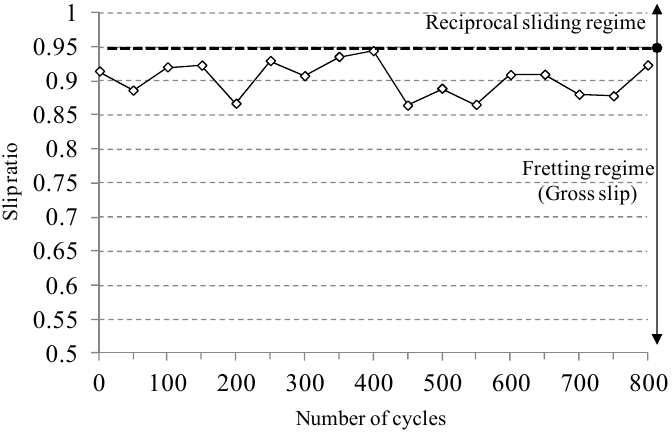
Figure 4. Slip ratios of an electro-deposited coating at a normal force of 49 N, an imposed displacement amplitude of 0.2 mm, and a frequency of 1 Hz.